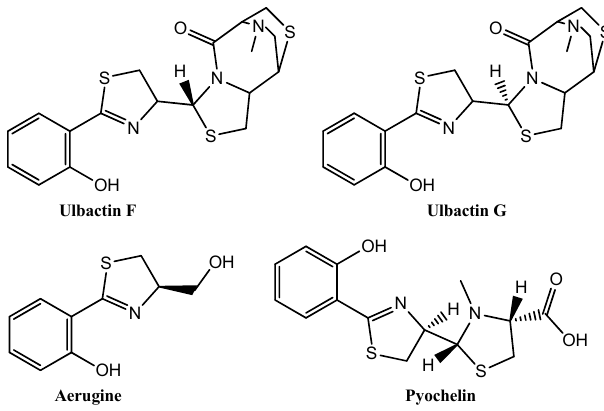
Figure 1. Some thiazoline containing anticancer molecules.